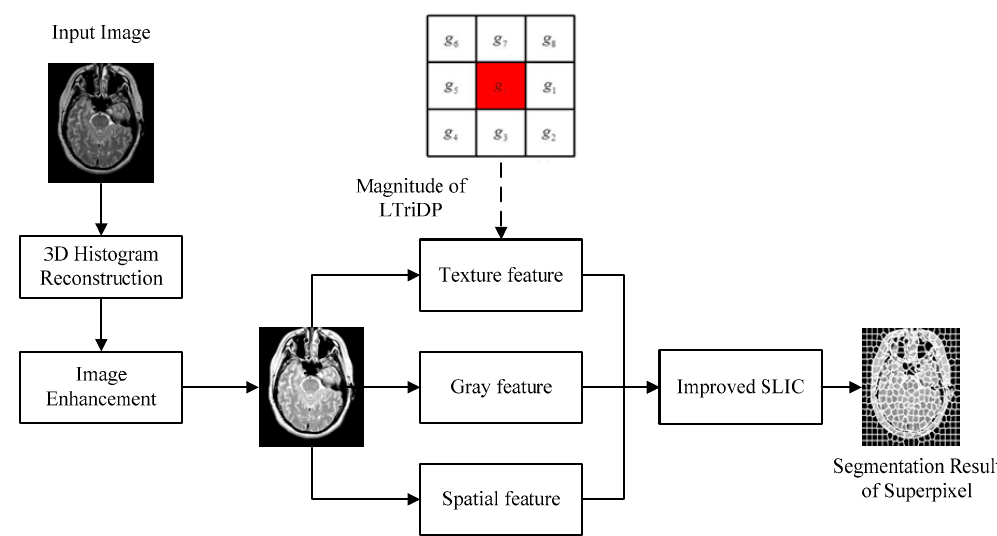
Figure 1. The framework of the proposed algorithm. LTriDP: local tri-directional pattern; SLIC: simple linear iterative clustering.